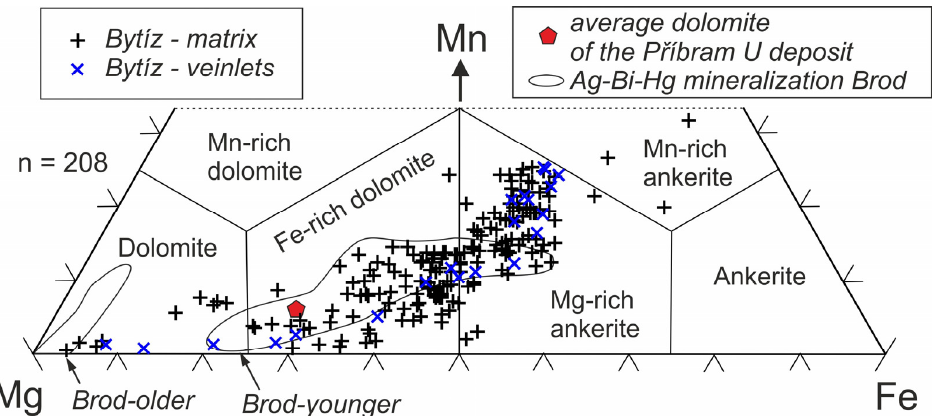
Figure 23. Chemical composition of carbonates of the dolomite–ankerite series from Bytíz in the Mg- Fe-Mn plot (modified from Trdli č ka and Hoffman [84]). Comparative data are from Cílek et al. [86] and Sejkora et al. [85].